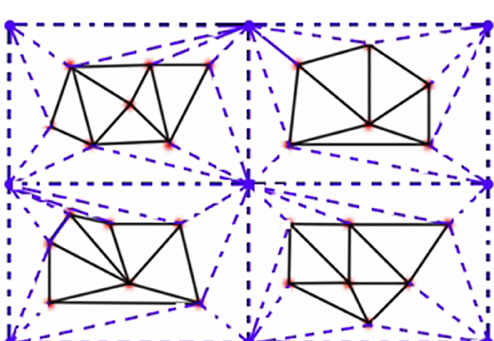
Figure 11. A topological query with B-tree index.